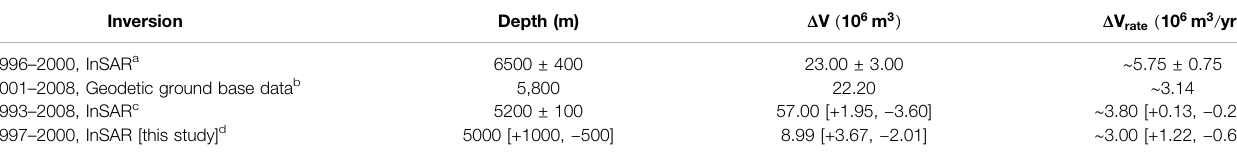
TABLE 3 | Source location comparison for Three Sisters (assuming a Mogi source) from Previous Studies and the bayesian inversion carried out in this Study.